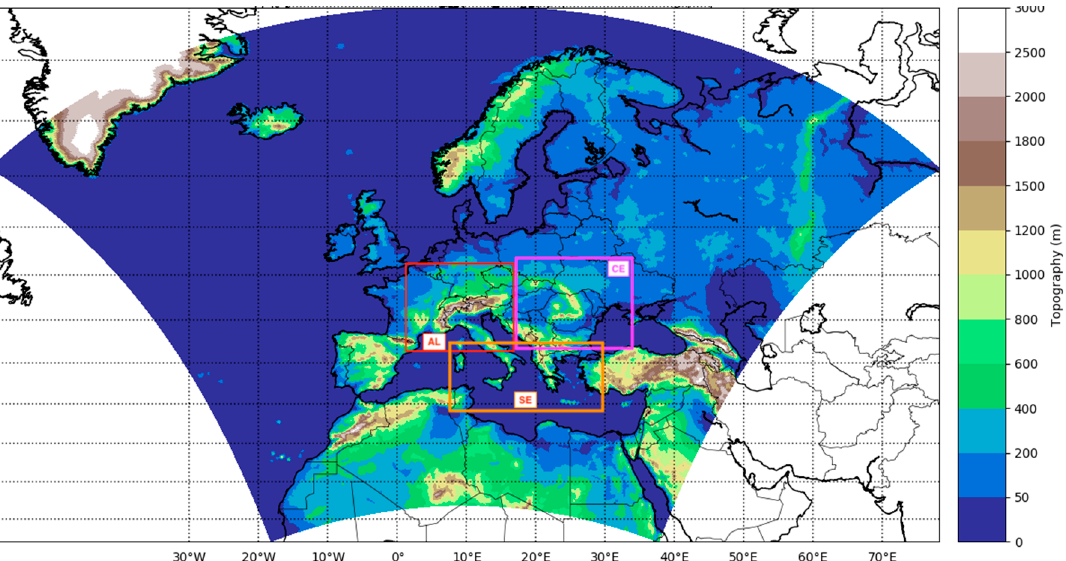
Figure 1. Set of domains simulated by CP-RegCM4-NH (3 km grid size) in EUCP project nested into EUR11 domain, simulated by RegCM4-NH (12 km grid size). The Alps (AL), red box; Central East Europe (CE), purple box; South East Europe (SE), orange box.